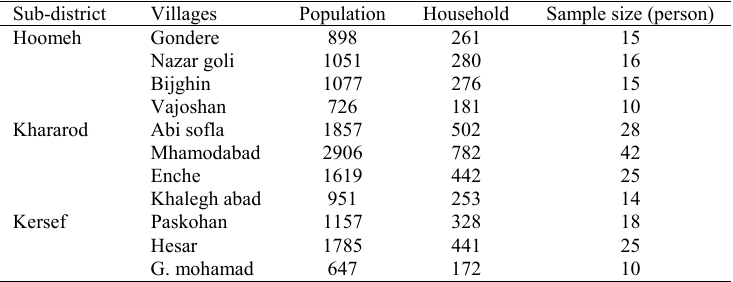
Table 1: Demographic status of studied villages